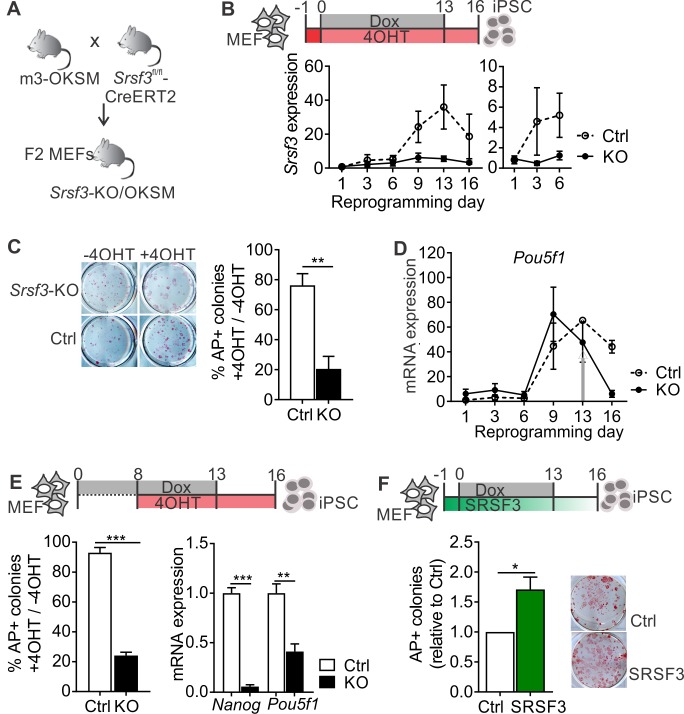
SRSF3 is essential for reprogramming.(A) The breeding strategy to obtain reprogrammable mice with a conditional Srsf3 knockout allele (Srsf3-KO/OKSM). (B) Experimental outline of the reprogramming experiments (top). Quantification of Srsf3 mRNA levels by RT-qPCR in SRSF3 depleted (KO) and control (Ctrl) cells in the course of reprogramming from day 1 to day 16 (left). Days 1–6 are shown on the right to visualise the expression changes within the first phase of reprogramming. Two-way ANOVA (***p=0.0002 for genotype, ***p=0.0008 for time and *p=0.0154 the interaction, data as mean ± SEM, n = 3–5). (C) Alkaline Phosphatase (AP) labelling of SRSF3 deficient (KO) and control (Ctrl) cells at day 16 of reprogramming (left) and quantification of AP-positive colonies (right). The data is presented as a relative number of colonies between treated (+4 OHT) and untreated (−4OHT) cells reprogrammed in parallel (Unpaired Student’s t-test, two-tailed, **p<0.01, data as mean ± SEM, n = 4–5). (D) Quantification of Pou5f1 mRNA expression by RT-qPCR during reprogramming in SRSF3 depleted (KO) and control (Ctrl) cells. The grey arrow denotes the point of Dox withdrawal and start of endogenous Pou5f1 expression (data as mean ± SEM, n = 2). The data is normalised to Hprt and presented relative to control MEFs. (E) Experimental outline (top) of experiments where MEFs were reprogrammed for 8 days before SRSF3 depletion. Quantification of AP positive colonies (left) and pluripotency marker expression (right) at day 16 of reprogramming as in (C). The AP counts and mRNA expression are presented as above (Unpaired Student’s t-test, two-tailed, **p<0.01, data as mean ± SEM, n = 4). (F) Experimental outline of the SRSF3 overexpression experiments (top). AP labelling of colonies at day 16 of reprogramming and quantification of AP-positive colonies. The data is presented relative to GFP-only (Ctrl) transfected cells (Unpaired Student’s t-test, two-tailed, *p<0.05, data as mean ± SEM, n = 3). See also Figure 1—figure supplement 1.